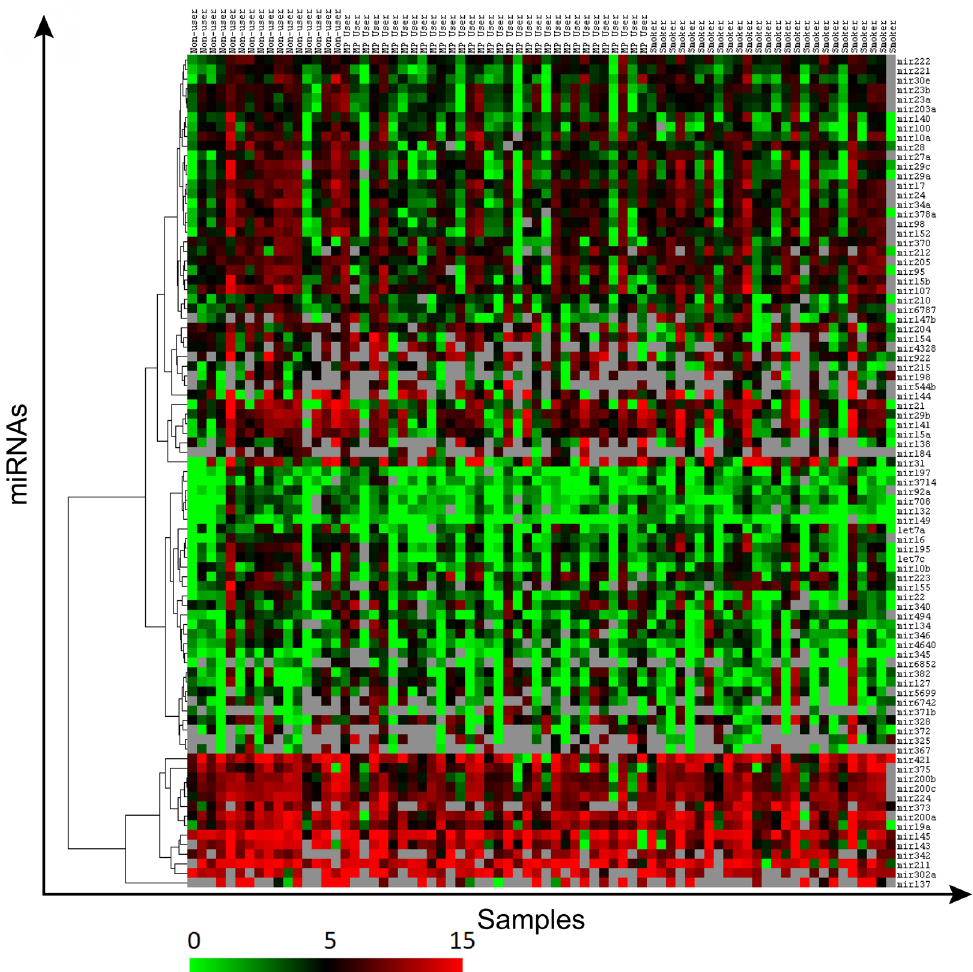
Figure 1- A heat map representing microRNA expression in nonusers, MP users and smokers. The clustering tree showing the concordance between miRNAs shown in the Y axis. Red tones on the heat map indicate higher expression levels than the median, while green tones show lower expression levels than the median